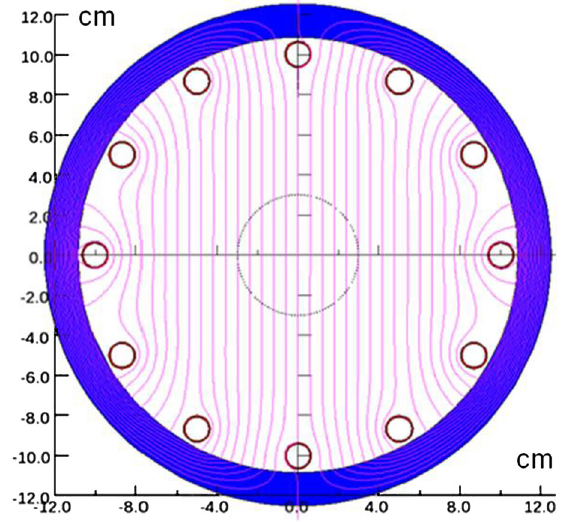
FIG. 2. Plot of flux on the combiner’s cross section (with 12 dipole coils and a ferrite core).